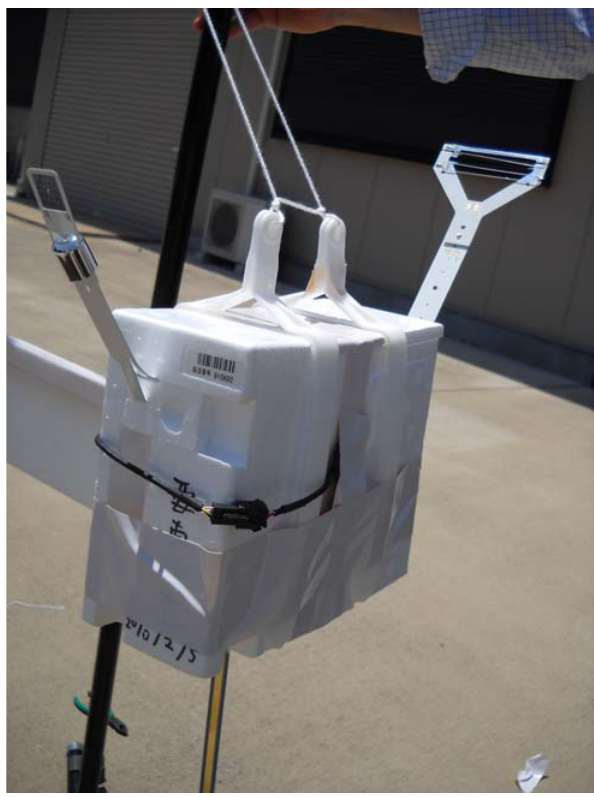
Fig. 7. Tungsten radiosonde with the modified sensor mount (far right) as compared to the conventional Meisei RS06G radiosonde (near left).